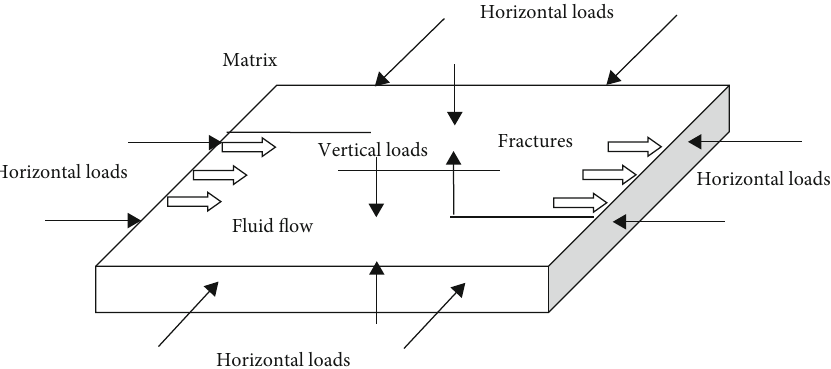
Figure 2: Similarity criteria model of physical simulation of water drive fractured reservoirs.